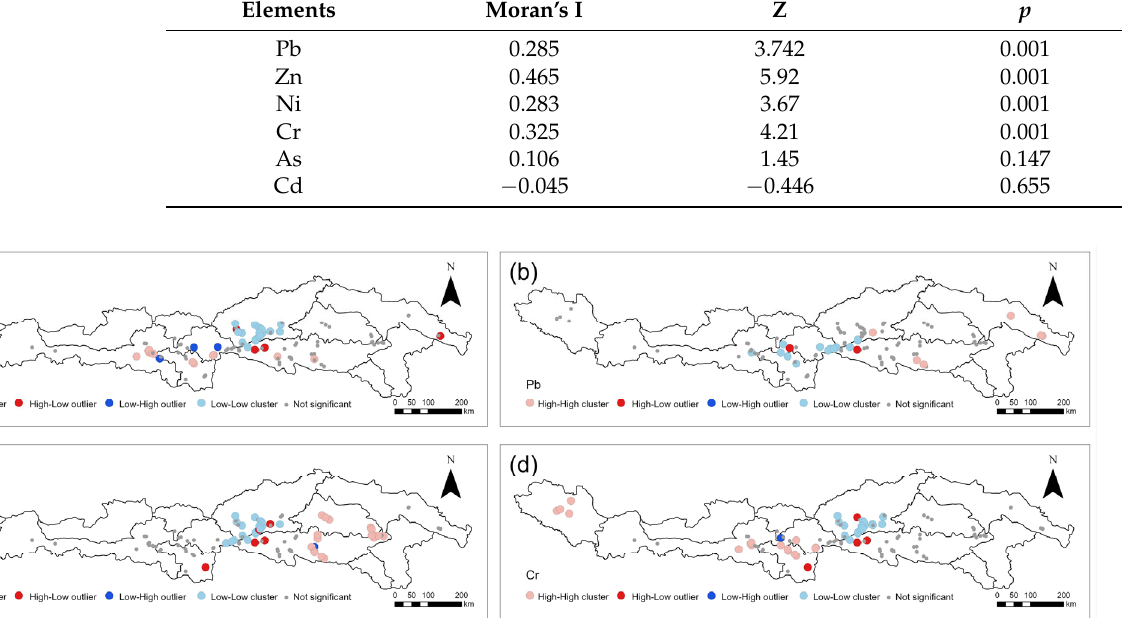
Figure 5. Aggregation maps of local indicators of spatial association. ( a ) Ni, ( b ) Pb, ( c ) Zn, ( d ) Cr.